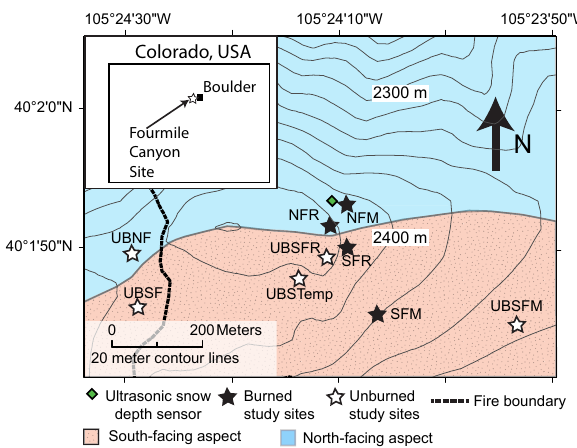
Fig. 1. Map of the experimental plots in the area affected by the 2010 Fourmile Canyon Fire near Boulder, CO, USA. Basemap from Sheila Murphy, US Geological